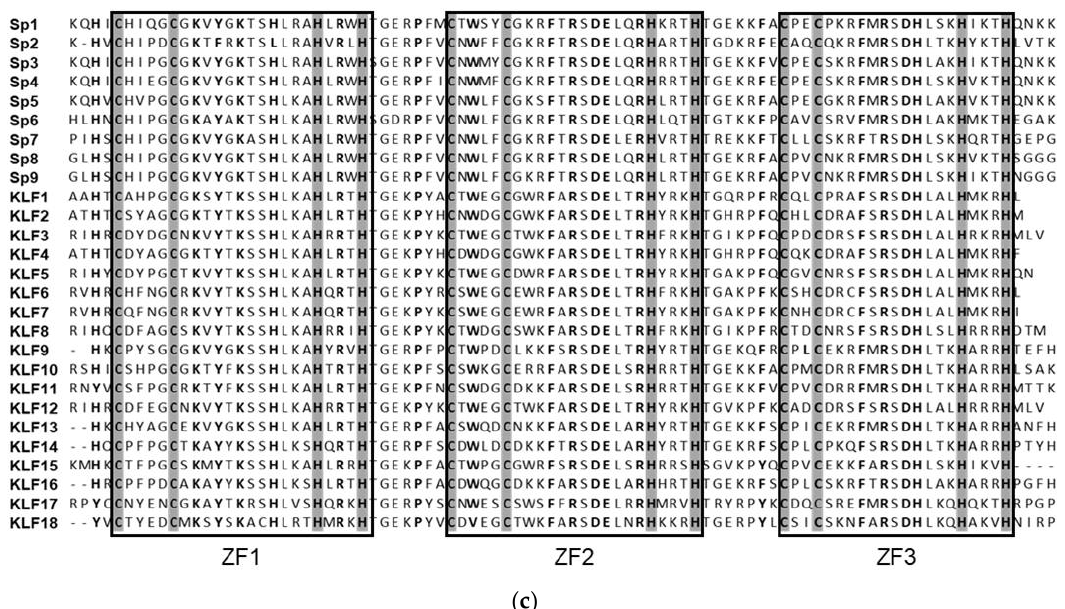
Figure 1. Phylogenic tree, common structure and zinc finger motif in SP (specificity proteins)/KLF (Krüppel-like Factors) family. ( a ) Phylogenic analysis based on human protein sequence from NCBI. ( b ) Structure of KLF family, KLFs isoforms can be divided into 3 groups based on the interaction of their N-terminal site with other proteins for transcriptional co-activators and co-repressors. Group 1 includes KLFs that contain the CtBP binding site. Group 2 includes KLFs that contain the Sin3A interaction domain. Group 3 includes KLFs that interact with acetyl-transferases. KLF15, KLF17, and KLF18 are not included in any of these groups because little is known about their protein interaction motifs and ( c ) multiple alignments of zinc finger domain of all family members of human Sp/KLF factors. Each protein contains three zinc fingers motifs at the C-terminus, two conserved cysteine residues and two conserved histidine residues for zinc binding are highlighted.